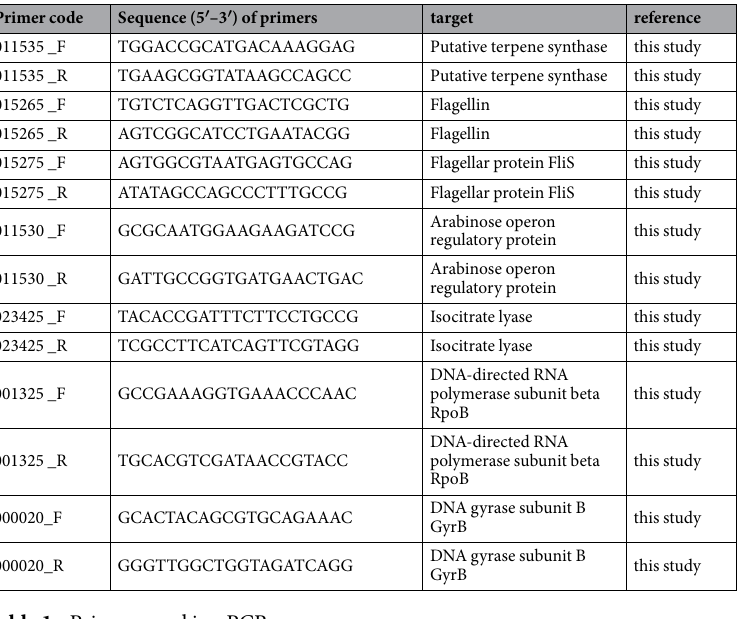
Table 1. Primers used in